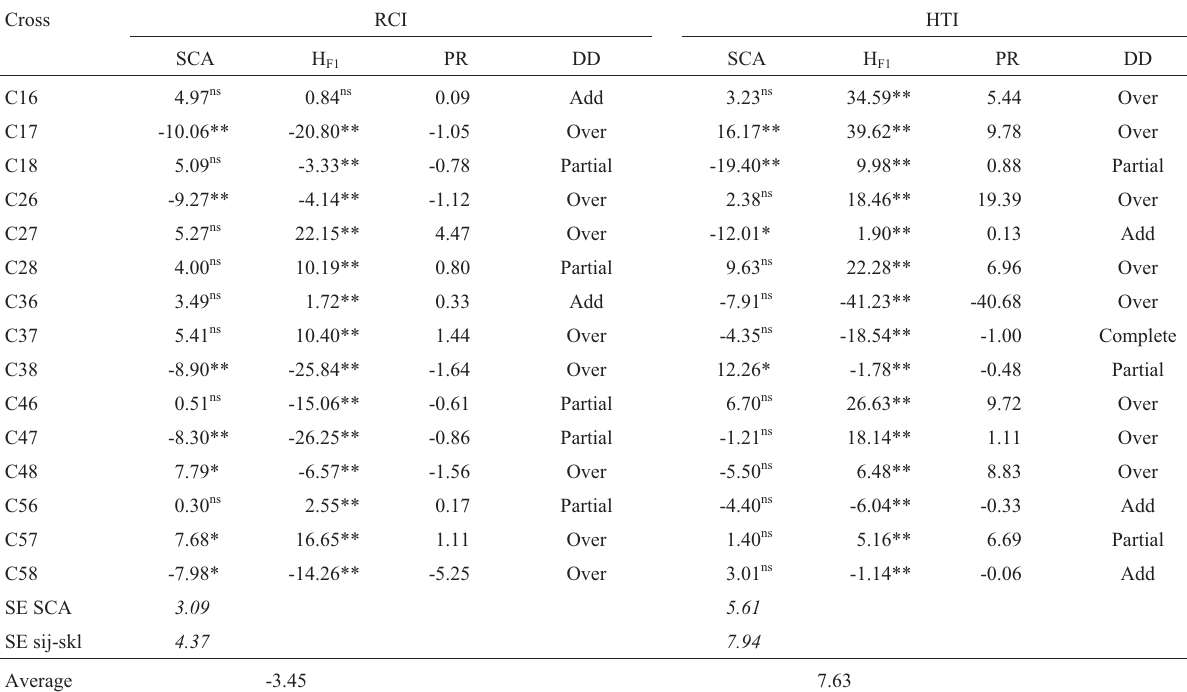
Table5 -Estimatesofspecificcombiningability(SCA)effects,midparentheterosis(H F1 ),potenceratio(PR),anddegreeofdominance(DD)forcellular membranethermostability(CMT)asmeasuredbyrelativecellinjury(RCI)inAprilandJunetemperatureregimesandheattoleranceindex(HTI)in2000 and 2001 crop years.